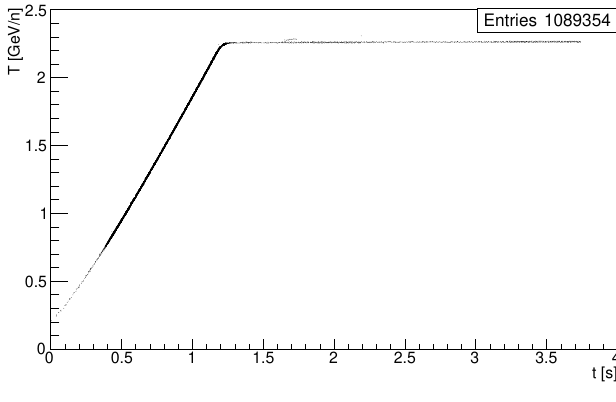
Figure 2. Dependence of the deuteron beam kinetic energy on time